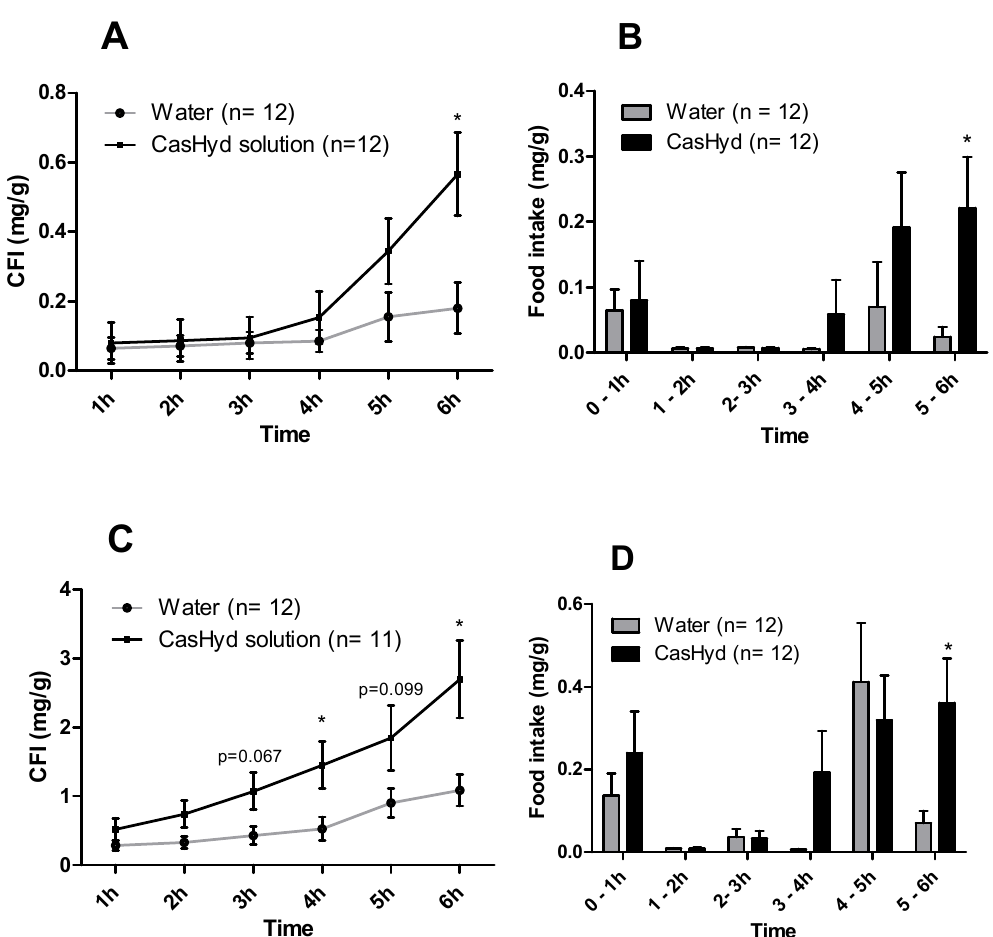
Figure 8. Cumulative food intake following oral administration of unencapsulated dairy protein-derived hydrolysates. Food (regular chow) intake in male ( A ) and female ( C ) Sprague-Dawley rats was determined following oral gavage with 50mg kg − 1 body weight of CasHyd over 6 h. Cumulative food intake (CFI) was determined at regular intervals after oral gavage. The food intake per time bin is also illustrated ( B , D ). Graphs represent the mean ± SEM. Statistical significance was determined using repeated measures ANOVA and estimation of parameters for food intake. Pairwise comparisons were carried out using Tukey’s post-hoc test, while independent samples t-tests were used for each individual time bin; statistical significance is depicted as * p < 0.05.